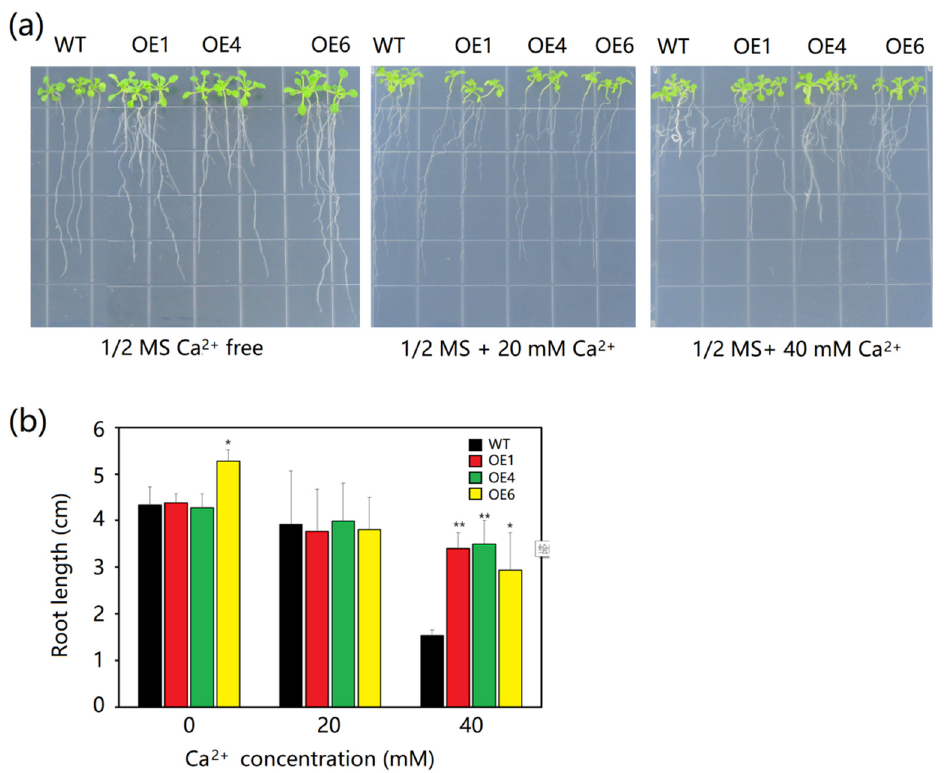
Figure 5. ( a ) Phenotype and ( b ) root length of transgenic Arabidopsis overexpressing MeAnn2 in re- sponse to a Ca 2+ concentration gradient. Error bars indicate ± SD. *, n = 3, p ≤ 0.05; **, p ≤